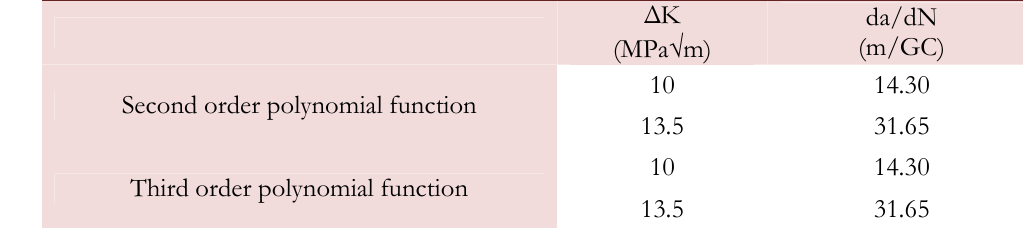
Table 5: Crack growth rates computed using the procedure